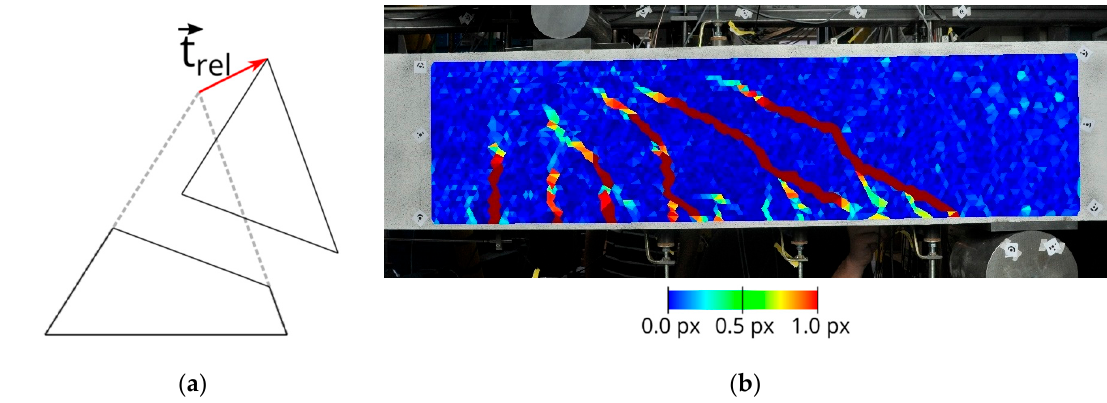
Figure 2. ( a ) Relative translation vector of a divided triangle; ( b ) color-coded map of the relative translation vector length ||𝑡⃗ (cid:3045)(cid:3032)(cid:3039) || for each triangle.